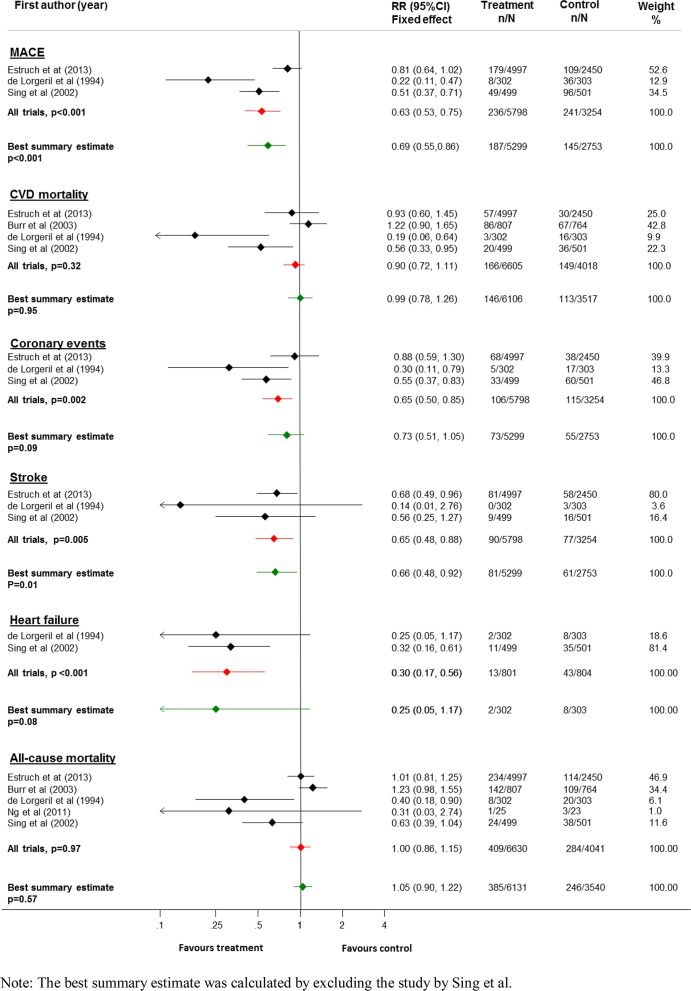
Forrest plot of the included studies showing relative risk of Mediterranean diet compared to control diet by various outcome measures (Fixed effects model analysis).